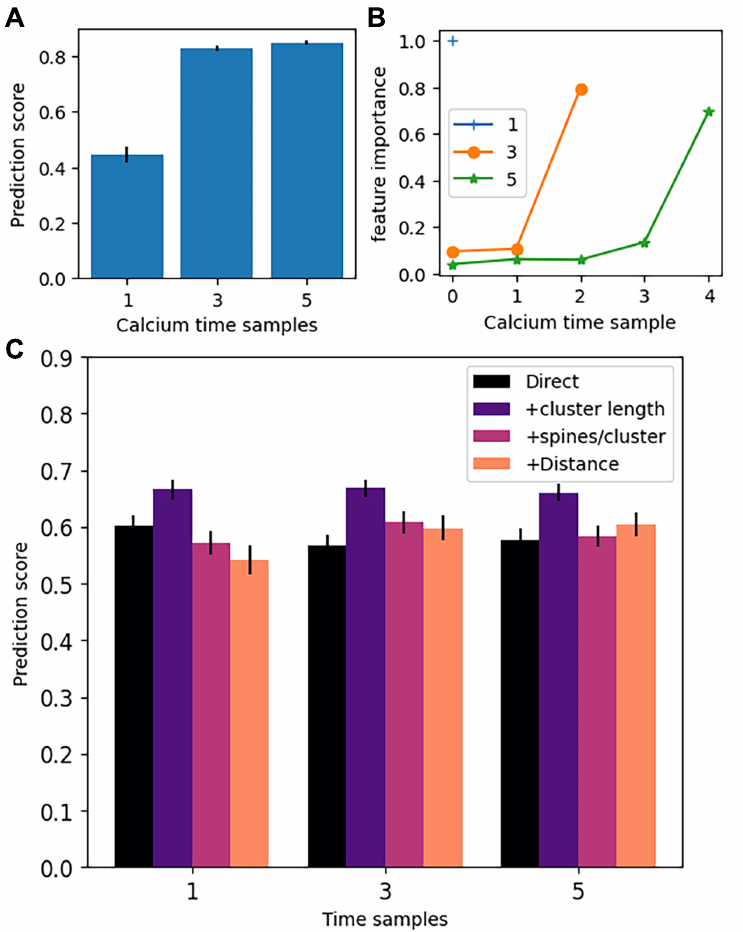
Figure 9. Spatiotemporal characteristics predict weight change. Prediction score is the coefficient of determination, R 2 , of the predicted weight change for the test set. For each of 5 sets of 25 simulations, we used 75% of the data as the training set and the remainder as test set, repeated 4 times giving a total of 20 regressions for each combination of features. Error bars show 1 standard error. ( A ) ANOVA shows that increasing number of time samples of calcium concentration improves the prediction score (F(2,60) = 165.7, p = 1.78 × 10 − 24 ). Post-hoc t-test shows that 3 samples is significantly better than 1 sample ( p = 2.84 × 10 − 15 ). ( B ) Feature importance shows that the last calcium time sample is the most important for predicting weight change. Note that the feature importances must sum to 1, so the feature importance for one calcium time sample is 1.0 by default. ( C ) A second set of random forest regressions used time samples of pre-synaptic firing frequency (direct) plus one other feature. An ANOVA on the other feature (none, cluster length, spines per cluster, and distance to soma) was significant (F(3,236) = 12.89, p = 7.88 × 10 − 8 ). Post-hoc t-test shows that cluster length, but no other feature, significantly improved the prediction score ( p = 2.2 × 10 − 7